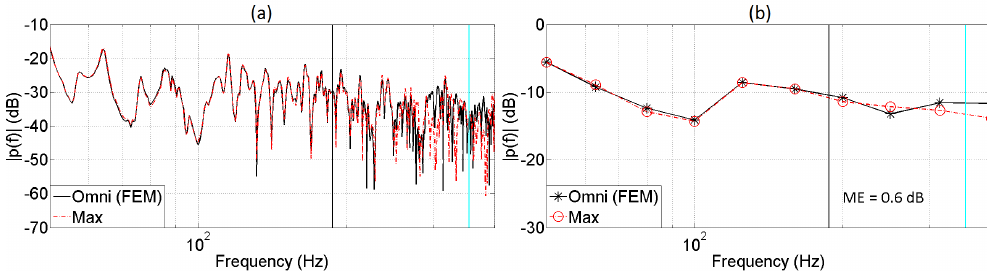
Figure 24. Comparison of full ( a ) and 1/3 octave band ( b ) frequency responses. Translated PWE and omnidirectional room impulse response (FEM) at translated Position 5. Table 2. Mean errors at different receiver locations. The distance to the central point of the expansion and the maximum frequency at which achieving an accurate reconstruction is expected are